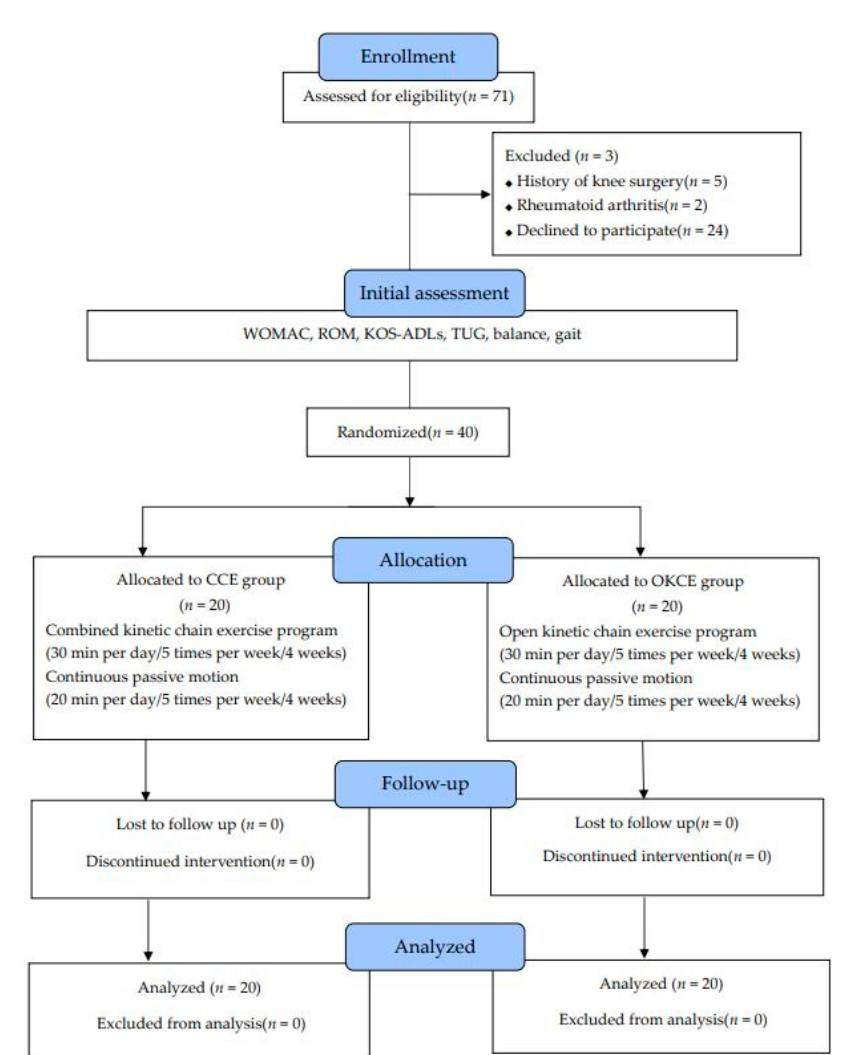
Figure 1. Flow diagram of the total experiment. CCE: combined kinetic chain exercise; OKCE: open kinetic chain exercise; WOMAC: the Western Ontario and McMaster Universities Osteoarthritis Index; ROM: knee range of motion; KOD-ADLs: Knee Outcome Survey-Activities of Daily Living.